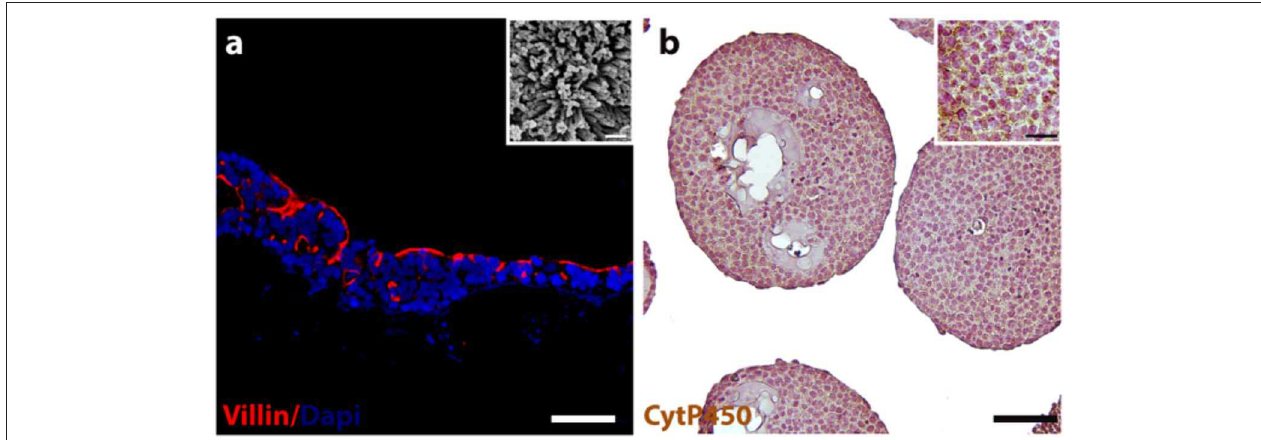
FIGURE 1 | 3D-HIM and HepG2- µ TPs functionality. Immunofluorescence analysis reveals the epithelial cells marker stained in red (villin) and nuclei in blue (DAPI) (a) ; scale bar, 75 µ m. High magnification SEM micrograph shows the brush border on the apical side of the villi-like structures of the 3D-HIM ( a , inset); scale bar 200nm; representative immune-histochemical image of Cyt P450 on HepG2- µ TPs (b) and high magnification inset, scale bar 75 and 50 µ m,